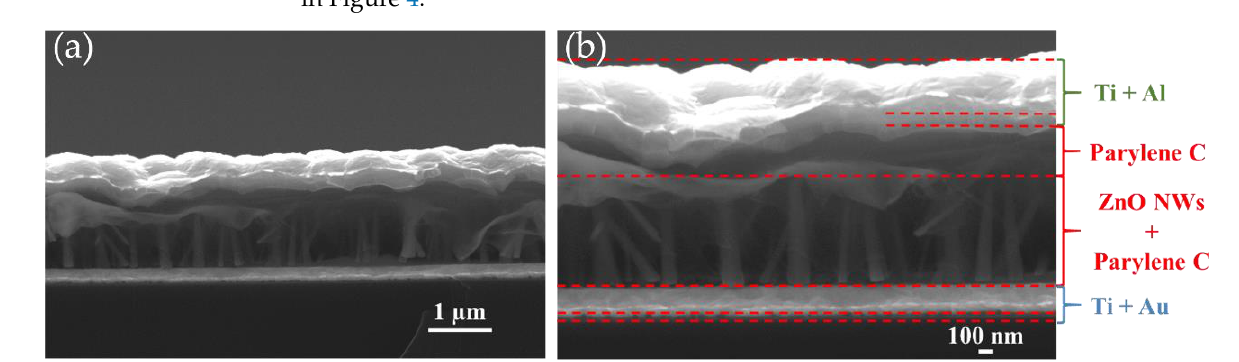
Figure 3 . Cross-sectional SEM images of PENG at ( a ) 15,000× and ( b ) 30,000× magnifications. Figure 3. Cross-sectional SEM images of PENG at ( a ) 15,000 × and ( b ) 30,000 × magnifications.